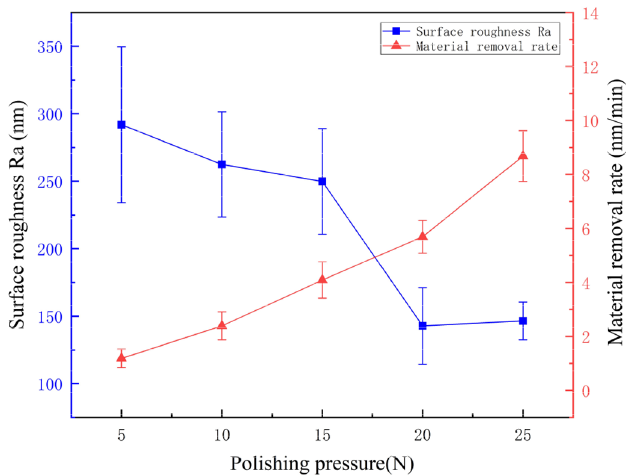
Fig. 6. Surface roughness ( R a ) and material-removal rate under different polishing